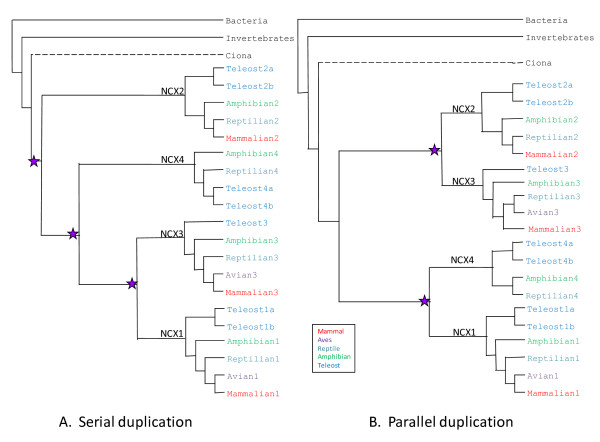
Summaries of Phylogeny Trees. Non-scaled, simplified representations of NCX evolution, rooted with a bacterial sequence is demonstrated with two manners of duplication: A. serial (Neighbour Joining) and B. parallel (Maximum Parsimony) duplication.